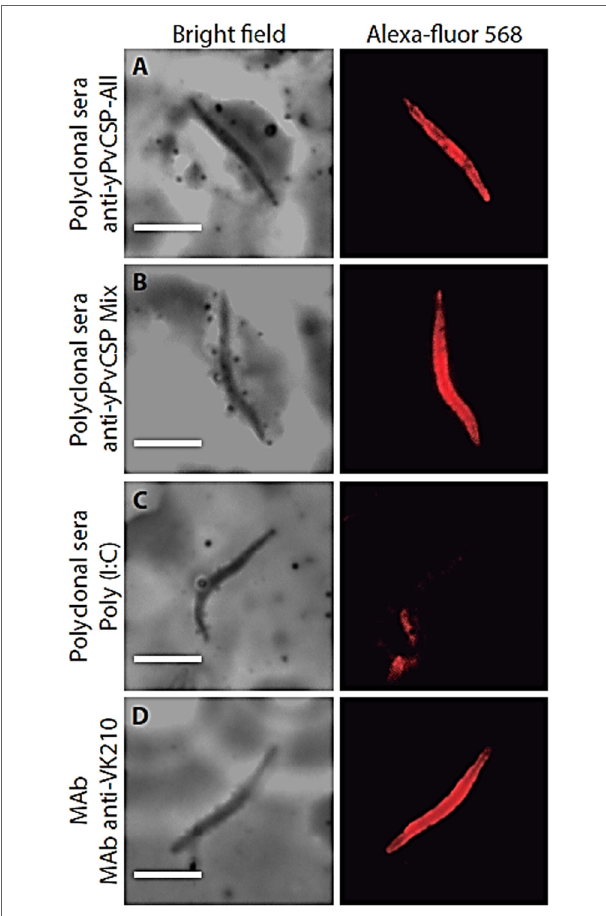
FigUre 5 | Recognition of native protein in Plasmodium vivax isolates. Indirect immunofluorescence analysis was performed using pool of sera (diluted 1:100) from C57BL/6 mice immunized with (a) yPvCSP-All epitopes, (B) protein mixture or (c) phosphate-buffered saline (PBS) in adjuvant, as a negative control . (D) As a control positive anti-PvCSP-VK210 (MAb 2F2) was used. Microscope slides containing wild-type P. vivax were obtained from Thailand isolates. Antibody binding was detected with secondary Alexa 568-labeled antibody (red) and nuclei were visualized by DAPI staining.